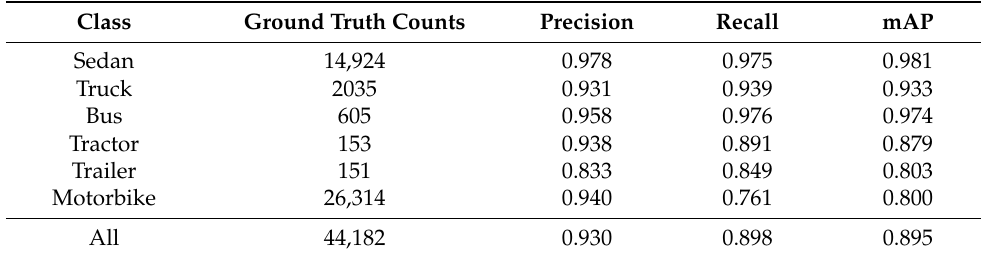
Table 1. Evaluation results of our